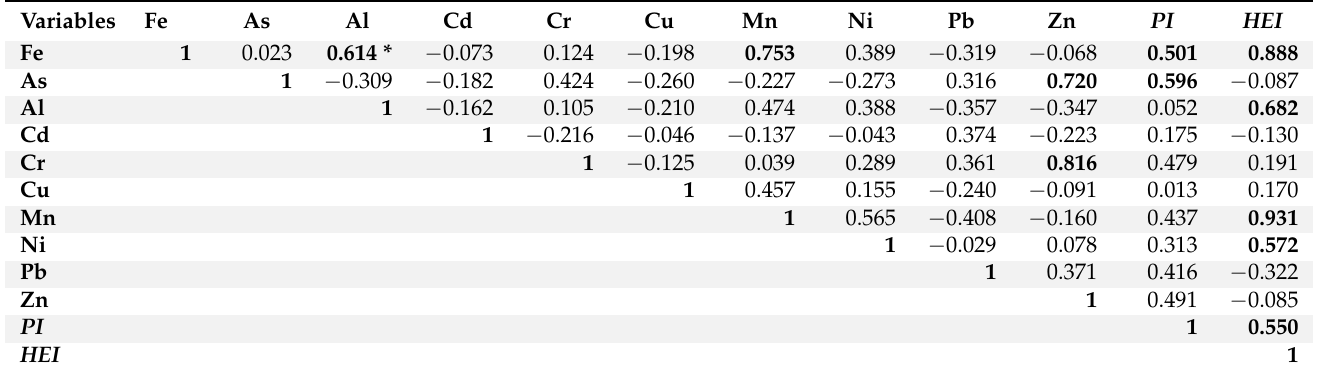
Table 3. Pearson’s correlation coefficient between the heavy metals and the PI, HEI scores.